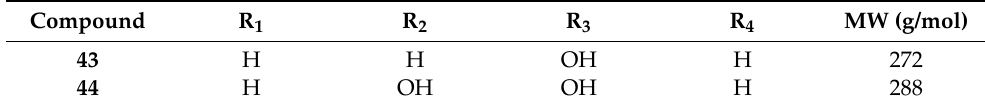
Table 6. Chemical structure of compound 43 and 44 . Compound R 1 R 2 R 3 R 4 MW (g/mol) 43 H H OH H 272 44 H OH OH H